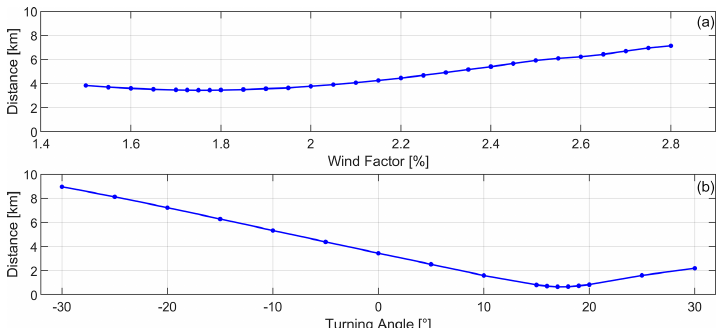
Figure A2. Distance between ERA-20C simulated and actual sinking sites as a function of wind factor (a) and turning angle (b) . These sensitivity results were used to arrive at the optimised parameter values for simulation Case 1 and the idealised values for Case 2.